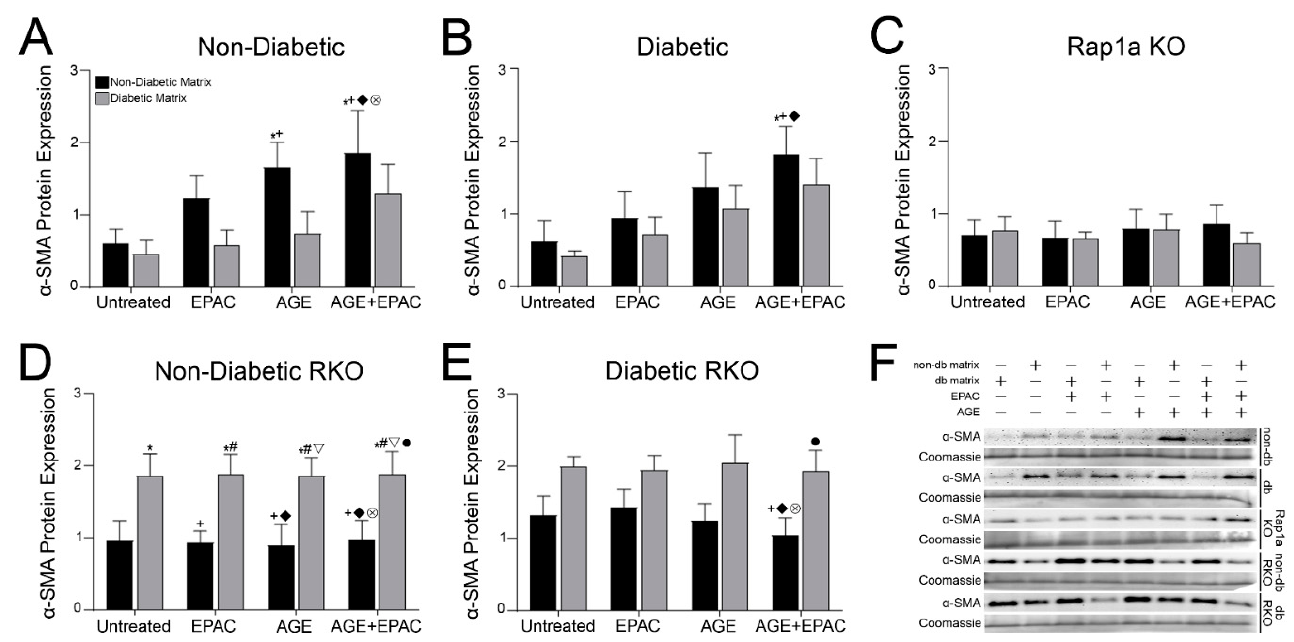
Figure 4. Isolated collagen and Rap1a mediated AGE/RAGE-induced increase of α -SMA expression in cardiac fibroblasts wildtype for RAGE. Cardiac fibroblasts were isolated from ( A ) non-diabetic, ( B ) diabetic, ( C ) Rap1a KO ( D ) non-diabetic RKO, and ( E ) diabetic RKO mouse hearts. Cells were embedded into non-diabetic (black bar) or diabetic (grey bar) collagen matrices for 7 days and then used to isolate total protein. Quantification of Western blot analysis for α -SMA (42 kDa) was assessed and normalized to total protein (Brilliant Blue Coomassie Stain) in untreated, EPAC (100 μ M), exogenous AGEs (0.05 mg/mL) and EPAC+exogenous AGEs (100 μ M and 0.05 mg/mL, respectively) cardiac fibroblasts. ( F ) Representative Western blot images for each treatment and genotype (non-db = non-diabetic matrix and db matrix = diabetic matrix). Data are means ± SEM with n = 5–10. Statistical analysis consisted of a two-way ANOVA followed by a Fisher’s Least Significant Difference post hoc. Symbols above each bar indicate significance between a specific group ( p < 0.05; * vs. untreated in non-db, + vs. untreated in db, # vs. EPAC in non-db, (cid:117) vs. EPAC in db, (cid:53) vs. AGE in non-db, ⊗ vs. AGE in db, and • vs. AGE+EPAC in non-db). Untreated treatment groups presented were initially presented in Figure 3B.